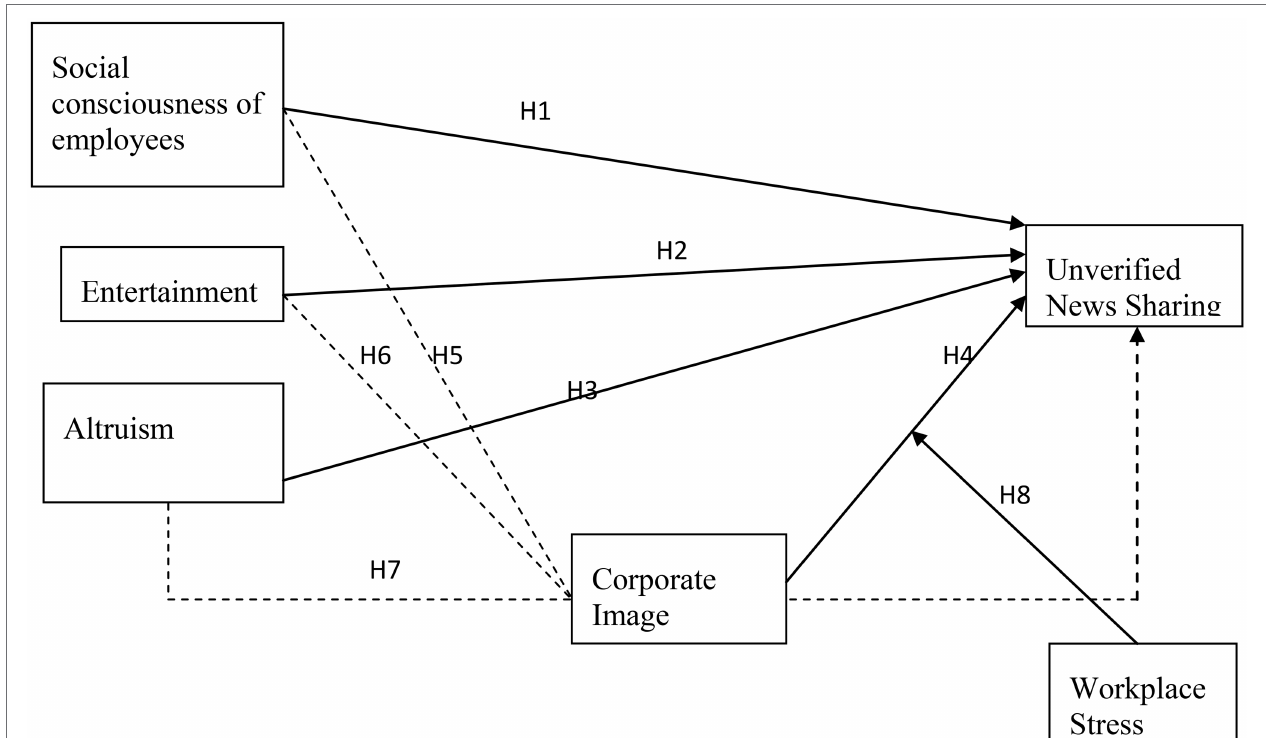
FIGURE 1 | Theoretical